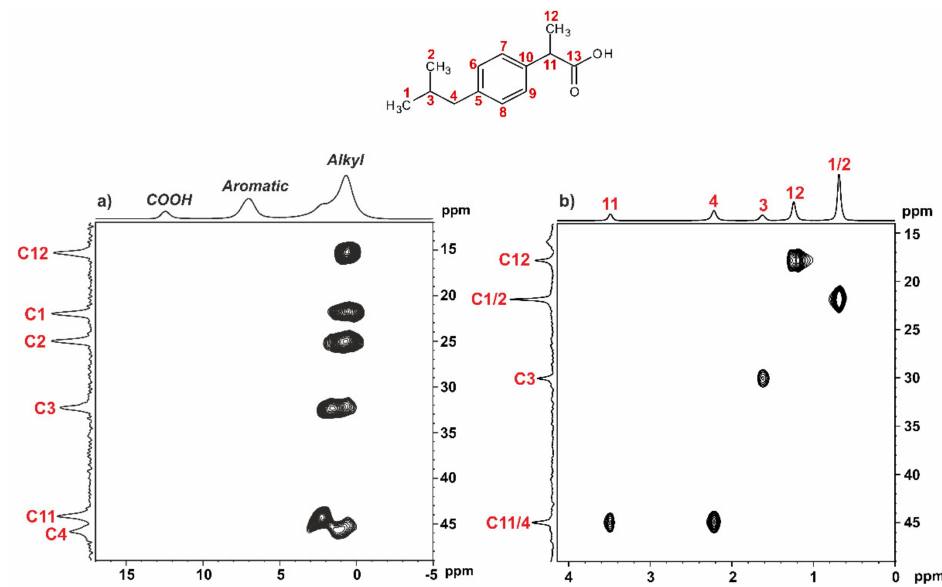
Figure 12. ( a ) 1 H– 13 C Inv-HETCOR NMR spectrum of Ibu recorded with a spinning rate of 60 kHz with contact time 2 ms; ( b ) 1 H– 13 C HSQC HR-MAS NMR spectrum of physical mixture of Ibu/MCM- 41 in a weight ratio of 1:3 after DiSupLo and after removed ethanol. Adapted with permission from [47], Copyright 2020